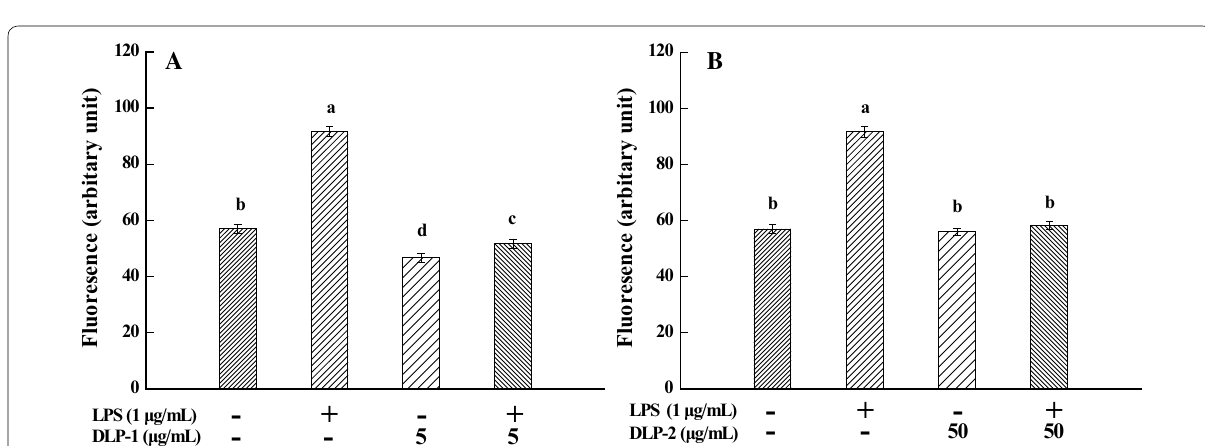
SD (n 6); bars with the same ± =